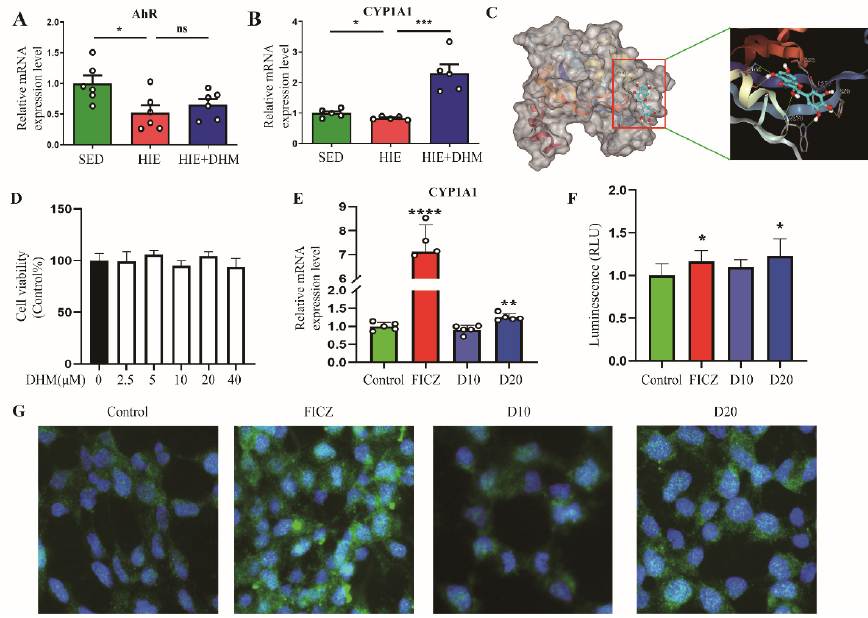
Figure 5. DHM attenuates HIE-induced intestinal barrier dysfunction associated with the activation of AhR. ( A , B ) The mRNA expression levels of the CYP1A1 ( A ) and AhR ( B ) in the small intestine tissues were assessed by qRT-PCR assay ( n = 5–6). ( C ) The binding conformation between DHM and AhR was predicted using the AutoDoc vina software, and DHM was shown as a ball-stick model with color by atoms. The hydrogen-bond interactions were highlighted using green dotted lines while the hydrophobic interactions were highlighted using gray dotted lines. The labeled protein residues were based on a licorice model. ( D ) HEK-293 cells treated with different concentrations of DHM for 24 h. Cell viability was measured with a Cell Counting Kit-8. ( E ) The mRNA expression levels of the CYP1A1 in HEK-293 cells were assessed by a qRT-PCR assay. ( F ) AhR-mediated transactivation in stably transfected HEK-293 cells. Cells were transfected with pDRE3 and treated with DMSO (control), 5 nM of FICZ, and DHM (10 and 20 µ M), and the luciferase activity was determined. ( G ) The nuclear localization of AhR (green) followed by DHM or FICZ treatment was determined by immunofluorescence staining. Nuclei were counterstained with DAPI (blue). Data were expressed as means ± SEM. The experiments were replicated 2–3 times. The data shown were from one representative experiment, * p < 0.05, ** p < 0.01 and, *** p < 0.001, **** p < 0.0001 and ns means not significant data. Multiple groups were tested by one-way ANOVA followed by Bonferroni’s post hoc